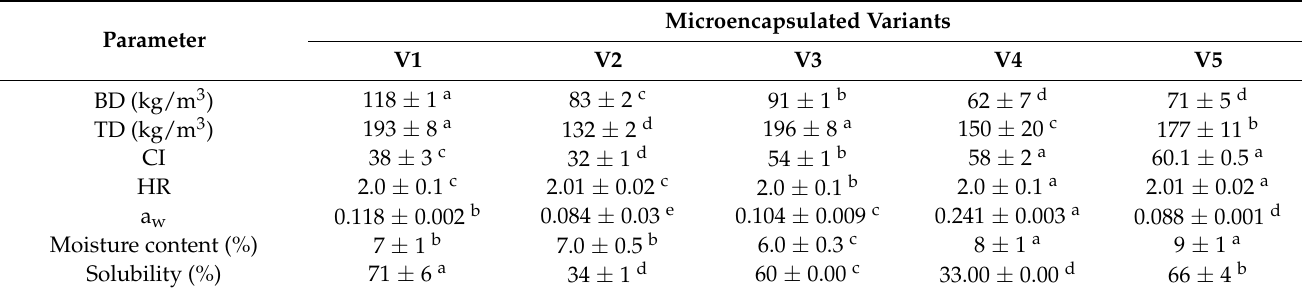
Table 4. Physical parameters of the microencapsulated